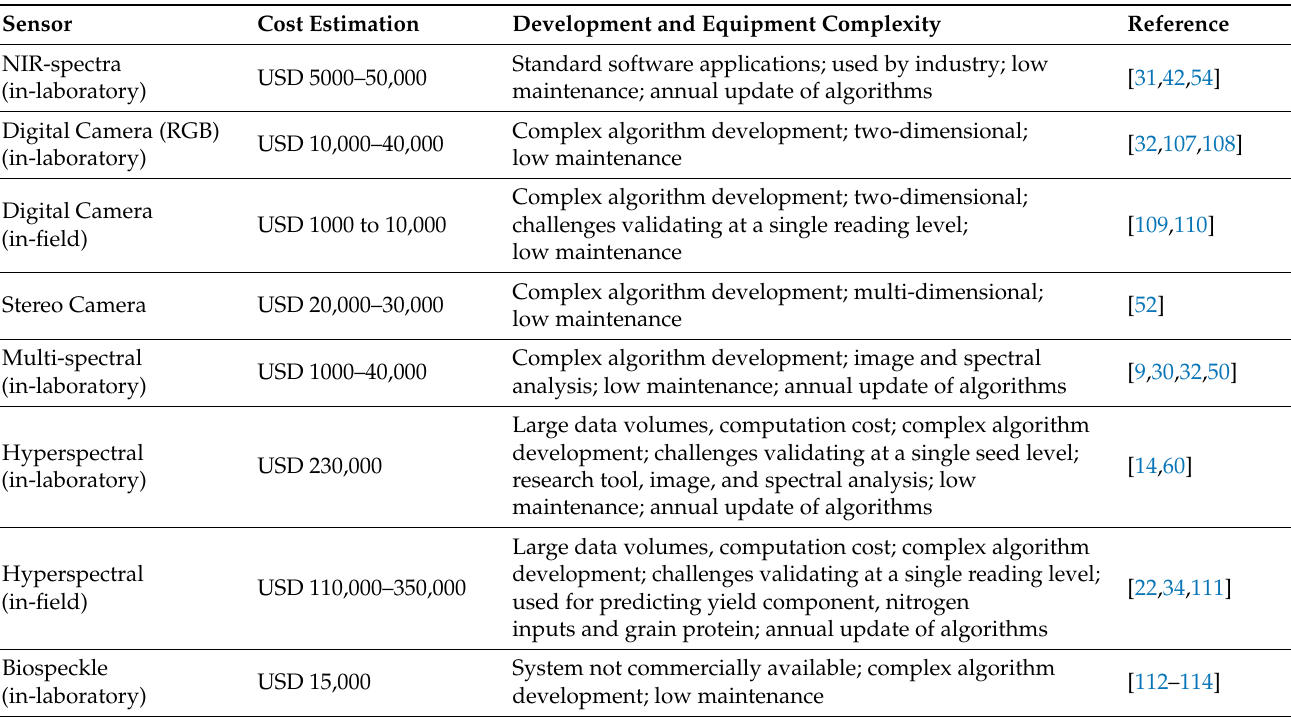
Table 3. Complexity and cost of sensor technologies used in agriculture to predict grain quality